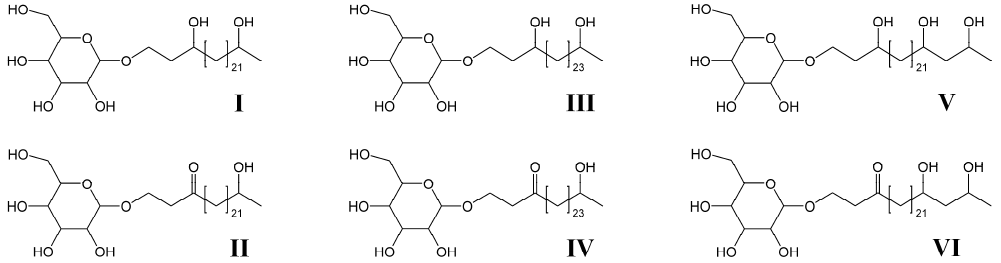
Figure 1. Structures of heterocyst glycolipids detected in water column filtrates and surface sediments of Lake Schreventeich. 1-(O- hexose)-3,25-hexacosanediol (I), 1-(O-hexose)-3-keto-25-hexacosanol (II), 1-(O-hexose)-3,27-octacosanediol (III),